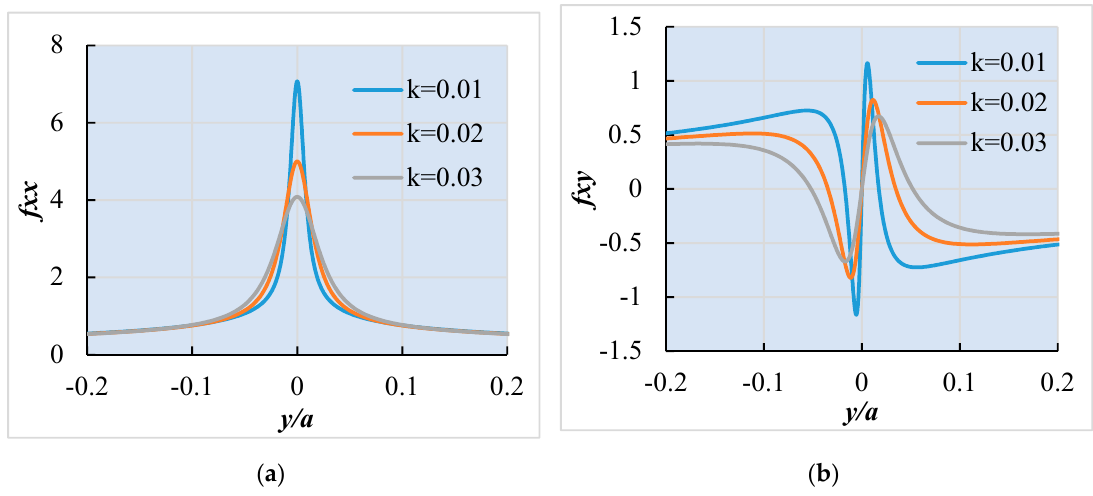
Figure 9. Induced stress coefficient of joint at fracture front of ( a ) normal stress; ( b ) shear stress.